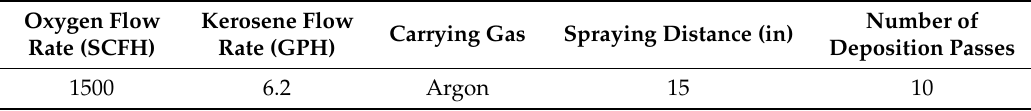
Table 1. HVOF spraying